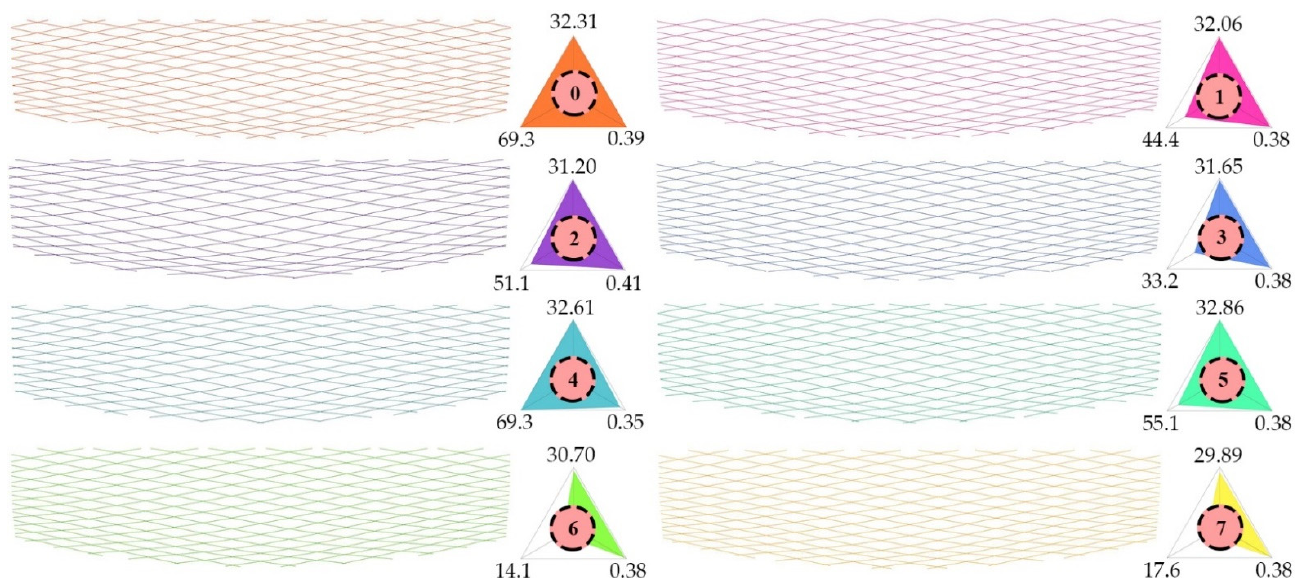
Figure 22. Space solution for 75 × 30 mm 2 cross-section, with maximum initial bending stress of less than 33 MPa in the study area. In the triangles, the middle number is the solution number; the upper vertex provides the maximum initial bending stress in the study area; the lower left vertex is the origin position in % (topological gene 1), and the right vertex is the opening angle in radians (topological gene 2).